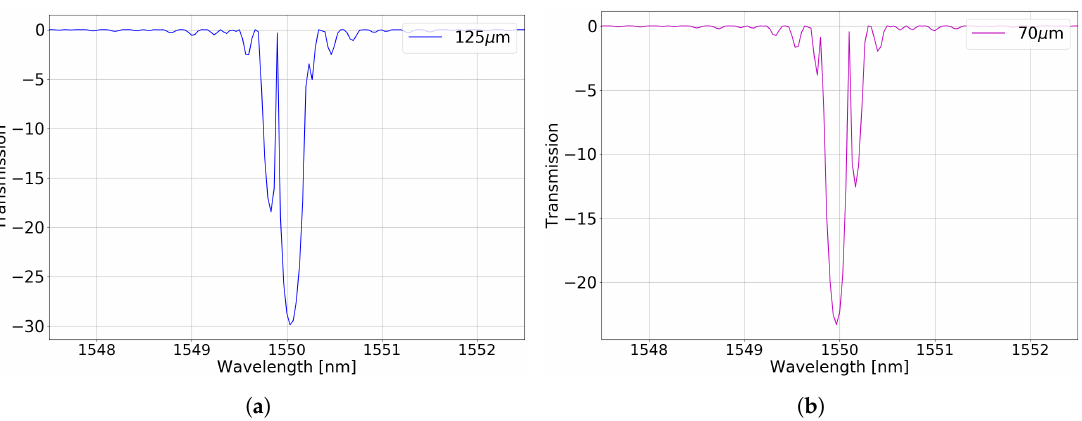
Figure 5. Transmission spectrum of FP structure: ( a ) 125 µ m diameter fiber; and ( b ) 70 µ m diameter fiber.